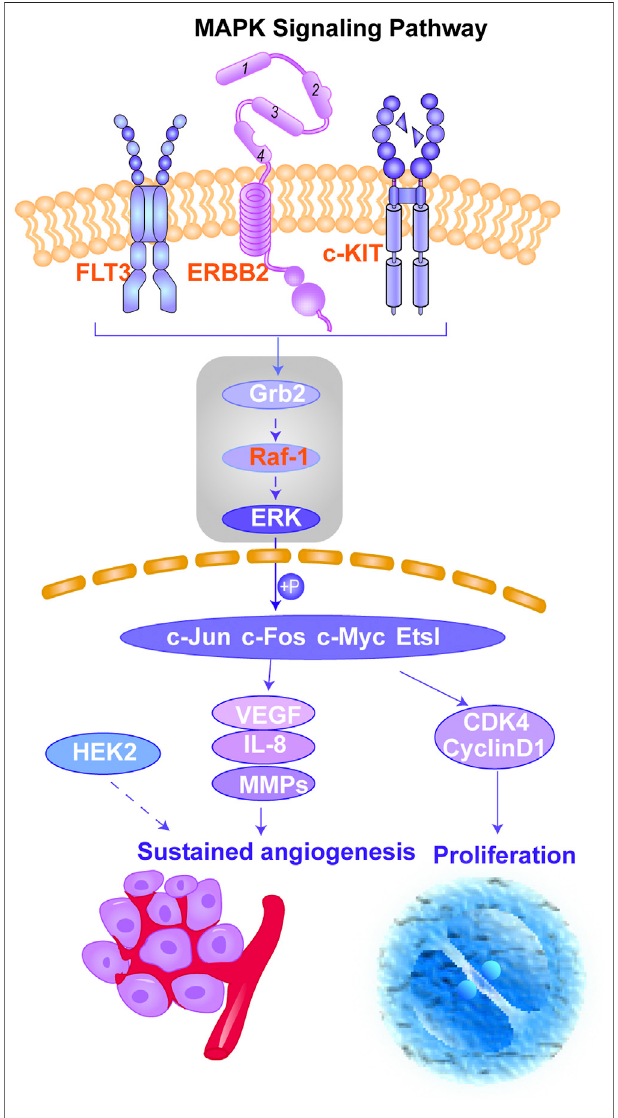
FIGURE 3 | Schematic of the MAPK signaling pathway. This fi gure shows the important cascades associated with the MAPK signaling pathway that involves in angiogenesis and cancer cell proliferation. The proteins marked in red represent the potential targets of erianin predicted in this study. The reported signaling pathways involved in anticancer mechanisms of erianin are framed in